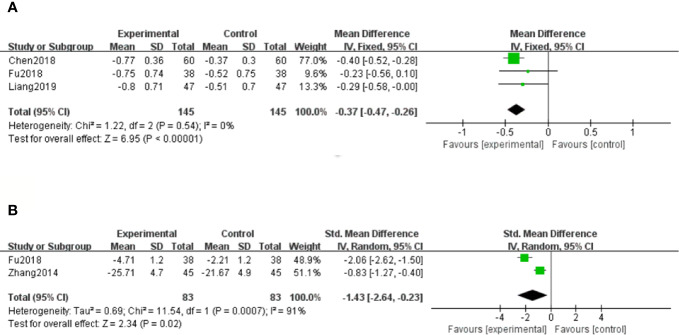
Forest plot for 24-hour urinary protein (24h Upro) between the treatment group and control group (A). Forest plot for albumin-to-creatinine ratio (ACR) between the treatment group and control group (B).